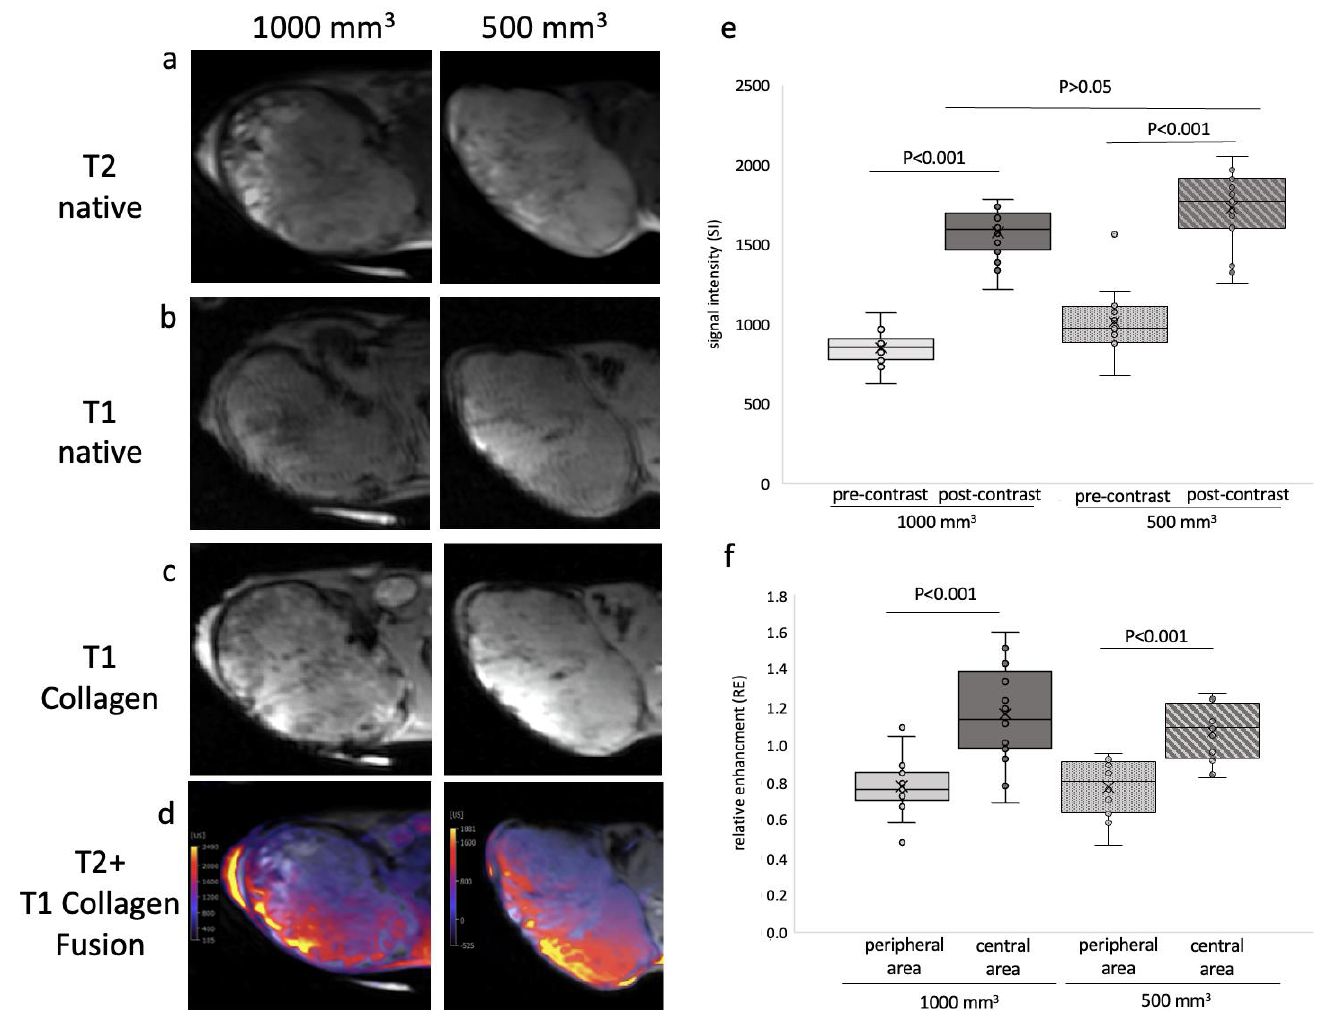
Figure 2. MRI images of prostate cancer in xenograft model of two different tumor sizes, 500 mm 3 and 1000 mm 3 . ( a ) shows a representative native MRI image of a T2-weighted sequence from a mouse that developed a tumor with a volume of 1000 mm 3 ( left ) and 500 mm 3 ( right ) in the scapula area of the mouse. ( b ) shows a native T1-weighted sequence of a tumor-bearing mouse. ( left ): 1000 mm 3 . ( right ): 500 mm 3 . Red arrows show the tumor. ( c ) shows a collagen-specific T1-weighted sequence with the collagen-specific probe of a tumor-bearing mouse. ( left ): 1000 mm 3 . ( right ): 500 mm 3 . Red arrows show the tumor. ( d ) shows a fusion map of the T2-native sequence and T1-probe administration in the same mouse. ( left ): 1000 mm 3 . ( right ): 500 mm 3 . ( e ) demonstrate the analysis of MR images (T1-weighted sequence) before and after collagen-specific administration in two tumor volumes, 500 mm 3 and 1000 mm 3 . Sixteen mice per group were studied in total ( n = 16). After administration of the collagen-specific probe, signal intensity (SI) changed in each case (SI of 500 mm 3 : pre-contrast: 916.7 ± 210.6, post-contrast: 1590.9 ± 295.7; SI of 1000 mm 3 : pre-contrast: 800.5 ± 103.6, post-contrast: 1482.0 ± 156.0). The data between pre- and post-contrast were significant ( p < 0.01). The SI data between post-contrast 500 mm 3 and post-contrast 1000 mm 3 was not significant ( p > 0.05). ( f ) shows the relative enhancement of the peripheral and central area of 1000 mm 3 ( left ) and 500 mm 3 ( right ) tumors. The RE data between the peripheral area and central area of 1000 mm 3 differ significantly ( p < 0.001, n = 16). The RE data between the peripheral area and central area of 500 mm 3 are significantly different ( p < 0.001, n =